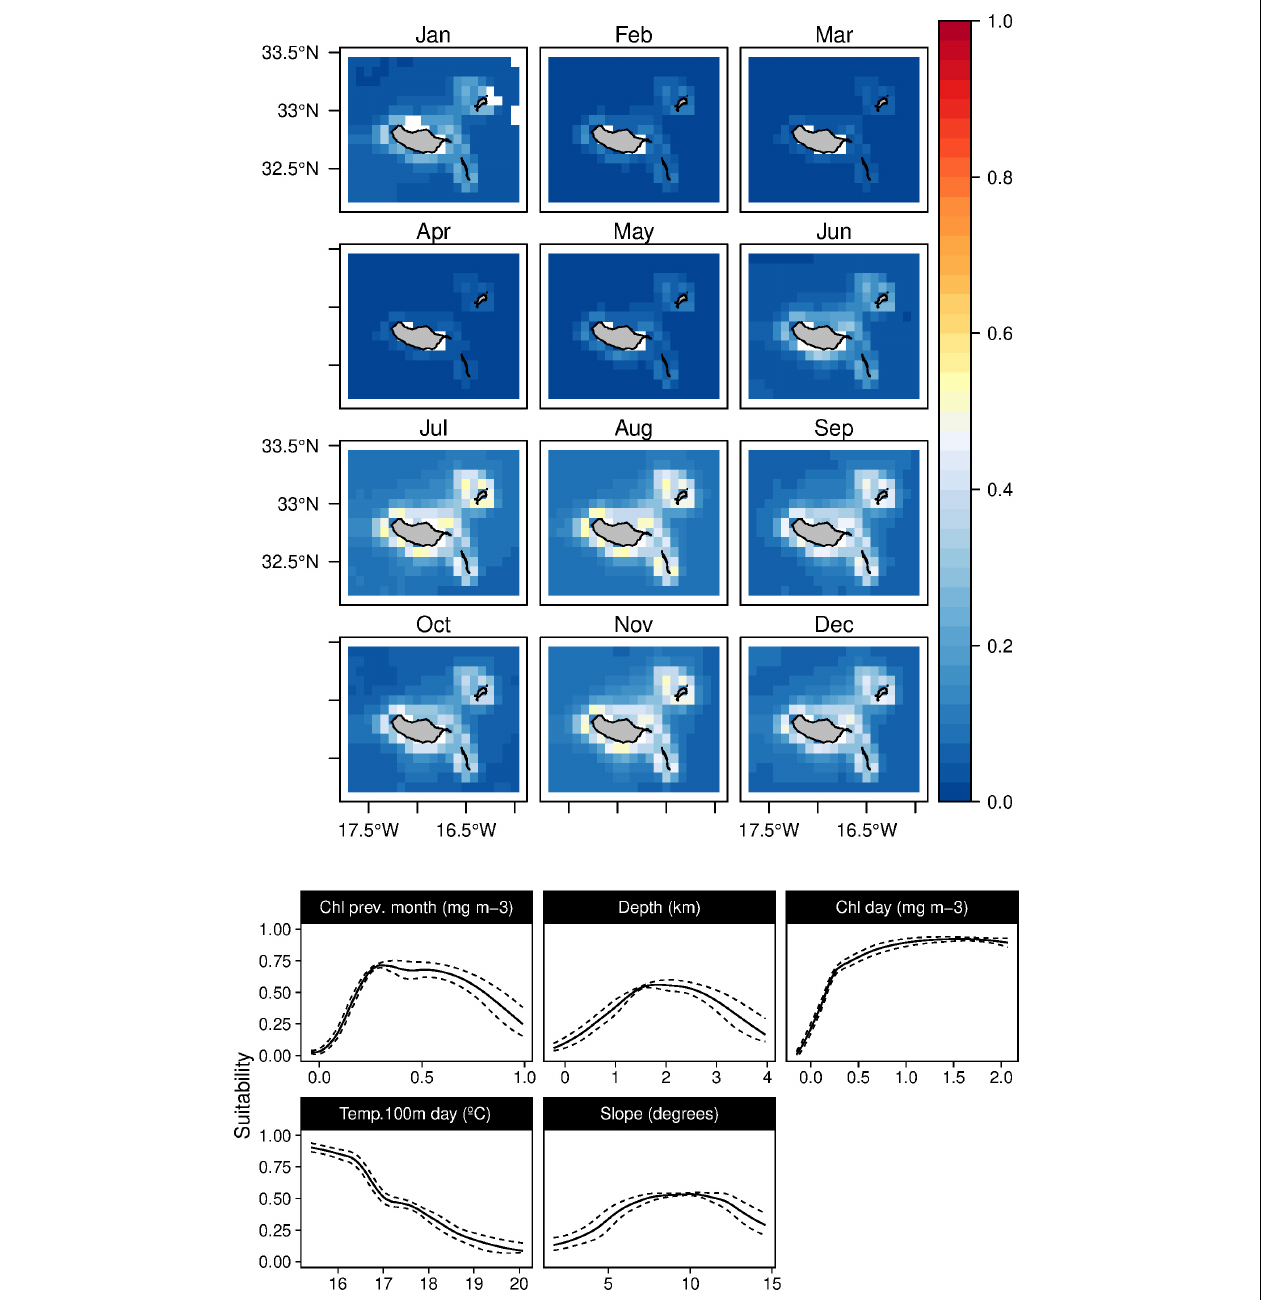
FIGURE 10 | Mean monthly suitability maps (above) and smoothed response curves with standard deviation (below) in the Madeira archipelago for Balaenoptera physalus for the “daily” models. In the maps, red represents more suitable and blue less suitable. Responses curves are ordered by percent contribution of the environmental